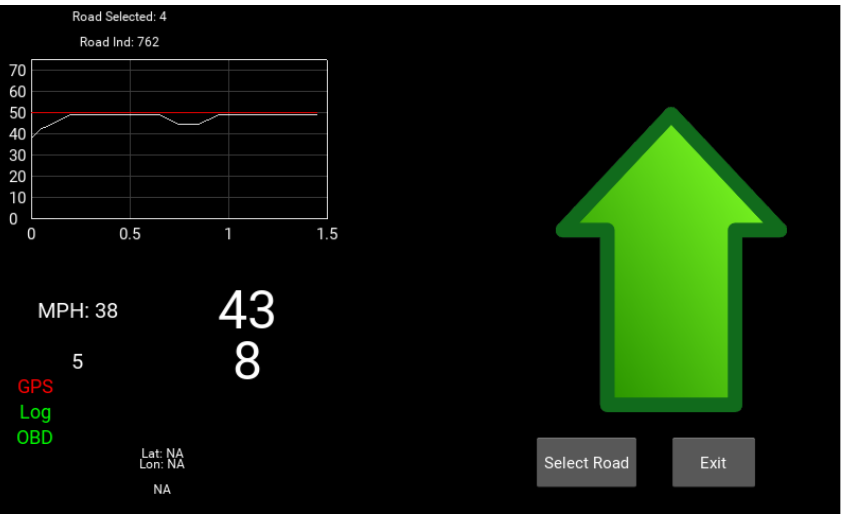
Figure 6. Driver feedback GUI with guidance to increase speed based on current speed (38) and aim speed (43) with current gear (5) and guidance gear (8). Status of GPS, datalogger (Log) and vehicle data connection (OBD) shown for testing purposes. Optimal Velocity profile shown on plot with speed limit for current road selection and position along that